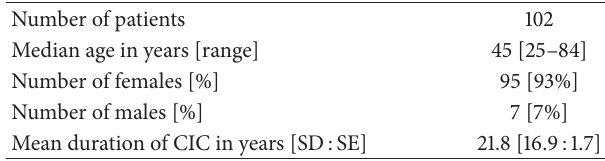
Table 1: Baseline demographics .